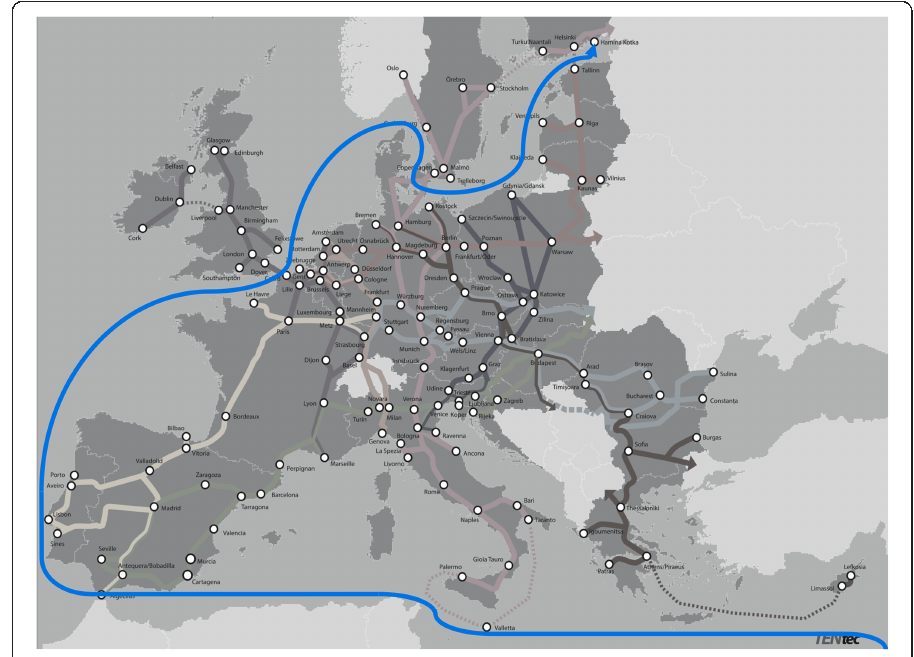
Fig. 6 Shipping routes from China and the Southeast Asia to Europe (Steer